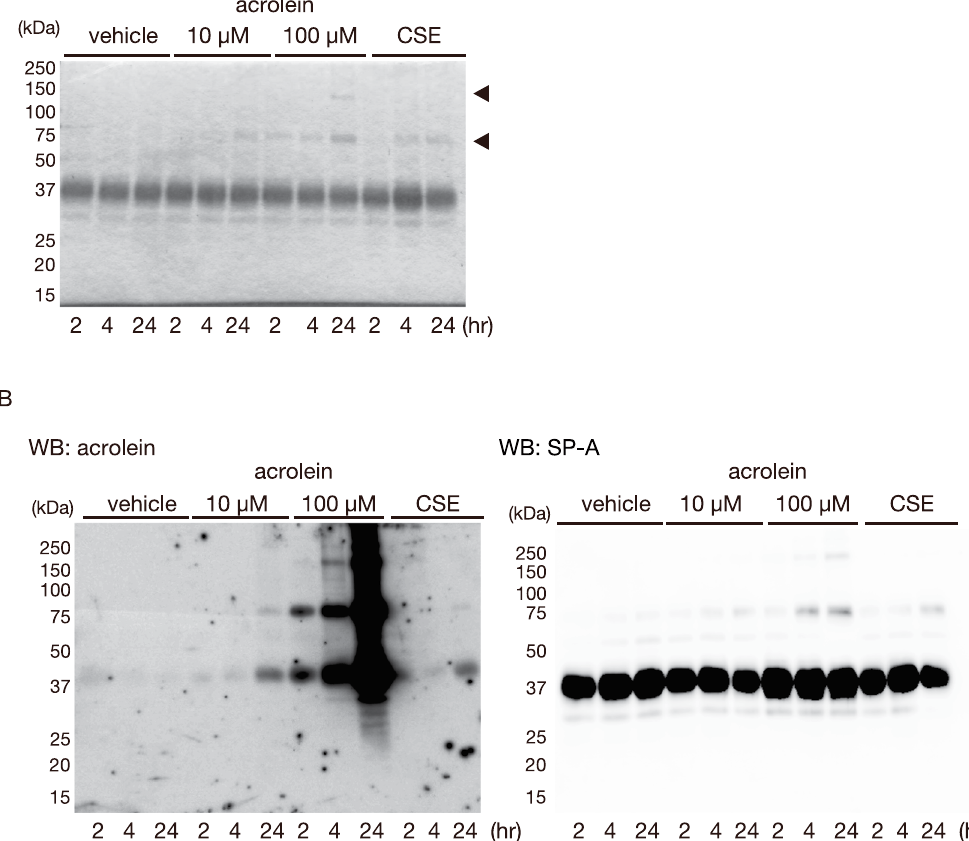
Figure 2. The acrolein modification of recombinant hSP-A by acrolein and CSE. Recombinant human SP-A (5 µ M) was incubated with vehicle, acrolein (10 or 100 µ M), or CSE (10%) at 37 °C for the indicated times, and 10 µ l aliquots were then subjected to SDS-PAGE. ( A ) A gel stained with Coomassie Brilliant Blue. Arrows indicate the positions of the oligomers. ( B ) Western blot analysis using anti-acrolein antibody (left) or anti-SPA antibody (right). These experiments were performed seven times, and representative results are